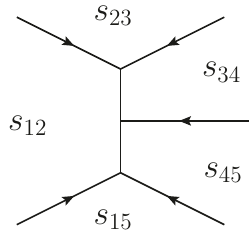
Figure 4 . Five-particle multi-Regge